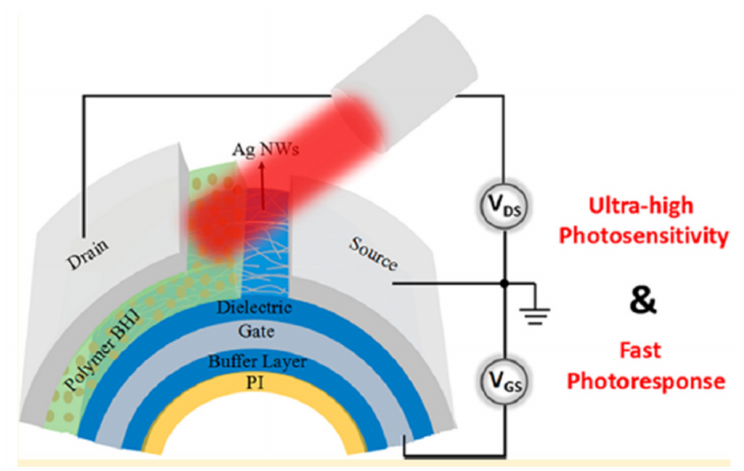
Figure 18. Device structure of highly flexible and novel OPT. Reprinted with permission from ref. [124]. Copyright 2018 American Chemical